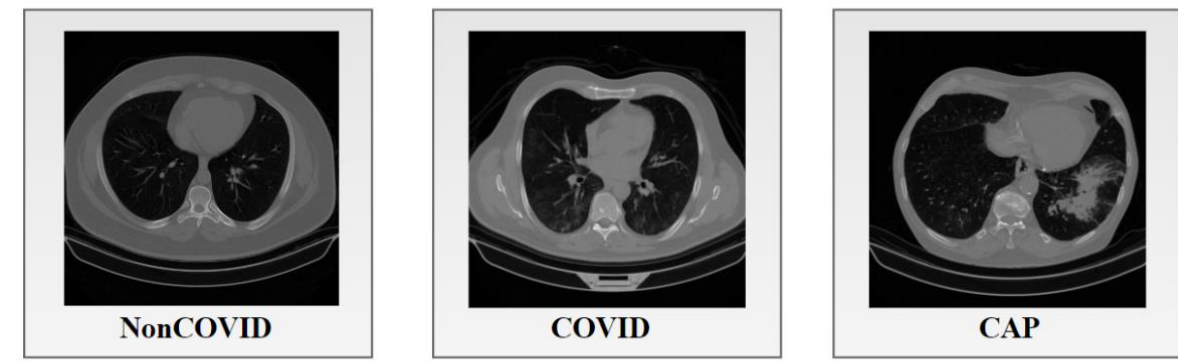
Figure 1. CT images of the three classes of the dataset.